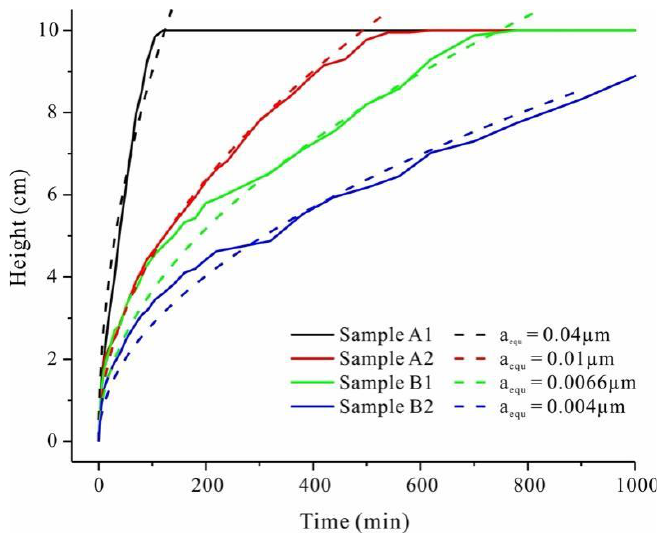
Figure 11. Comparison of the capillary imbibition curve reflected by the equivalent radius with the actual ones.